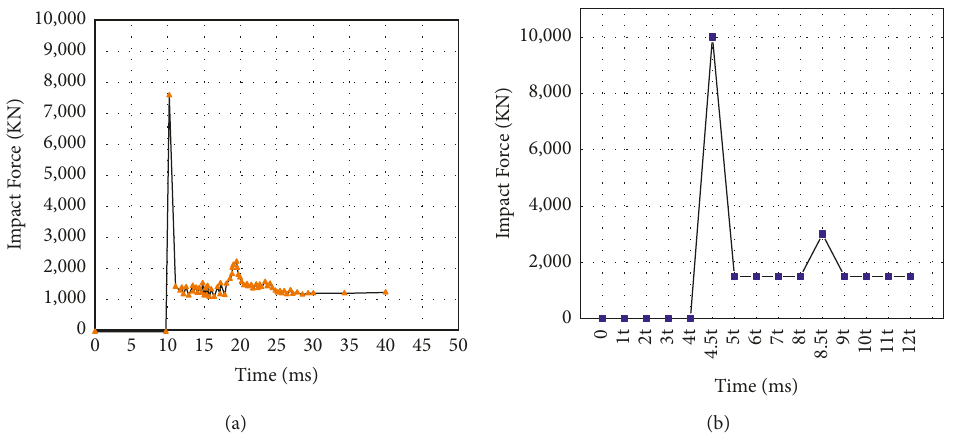
Figure 5: Impact force curve: (a) experimental parameter curve; (b) sampling curve and simulation